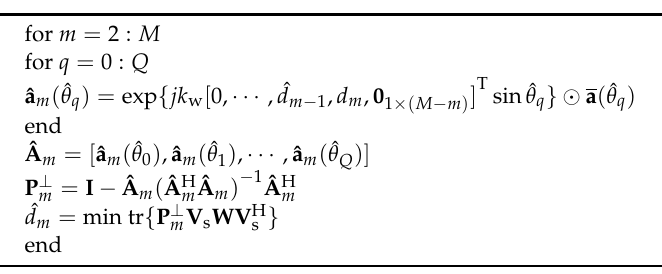
Table 1. Sensor position errors estimation algorithm.